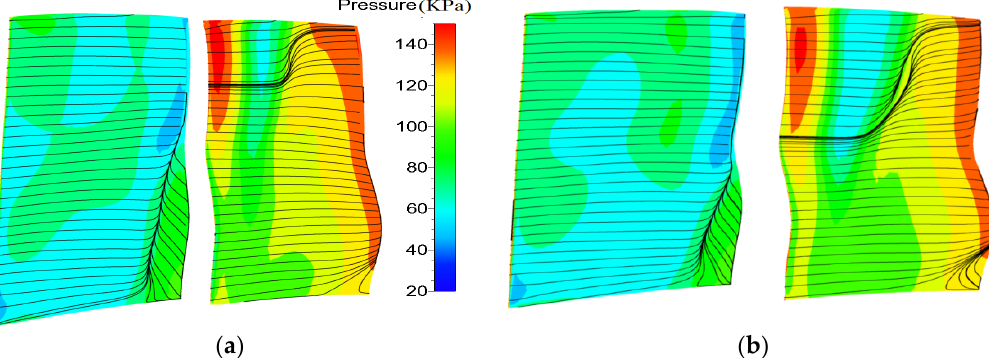
Figure 15. Static pressure and streamline of the suction surface of the original and optimized tandem rotor. ( a ) ORG; ( b ) OPT.